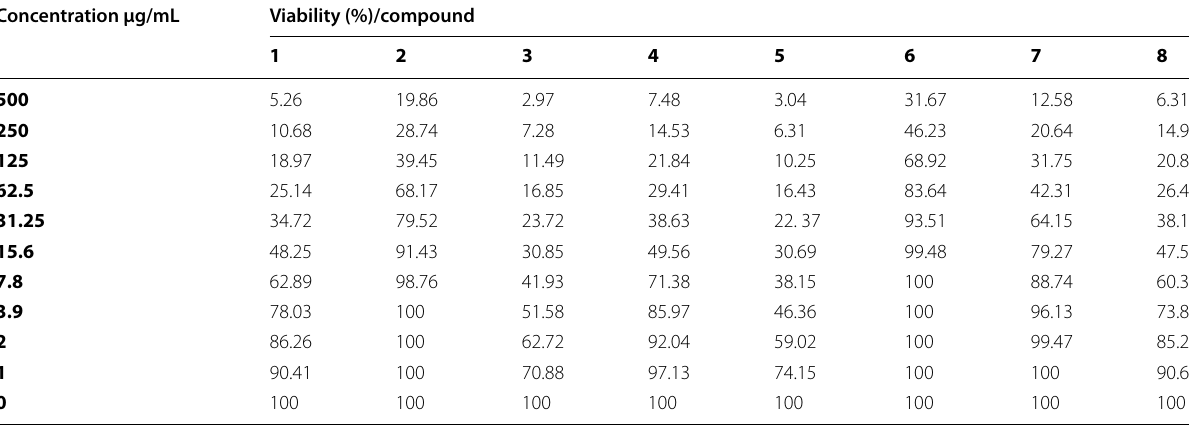
Table 1 Cytotoxicity of compounds 1, 2, 3, 4, 5, 6, 7 and 8 against hepatocellular carcinoma cell line HePG2 Concentration